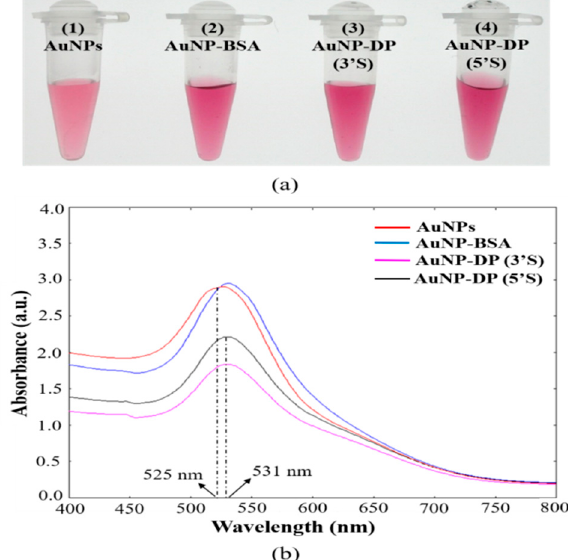
Figure 2. Evaluation of colloidal stability of the gold nanoparticle (AuNP) solutions. ( a ) Photographic images of the AuNP solutions: (1) AuNPs, (2) AuNPs coated with bovine serum albumin (AuNP-BSA), (3) AuNPs conjugated with 3’-thiol modified detector probe [AuNP-DP (3’S)], and AuNPs conjugated with 5’-thiol modified detector probe [AuNP-DP (5’S)]. ( b ) UV–VIS spectra of the solutions from ( a ).